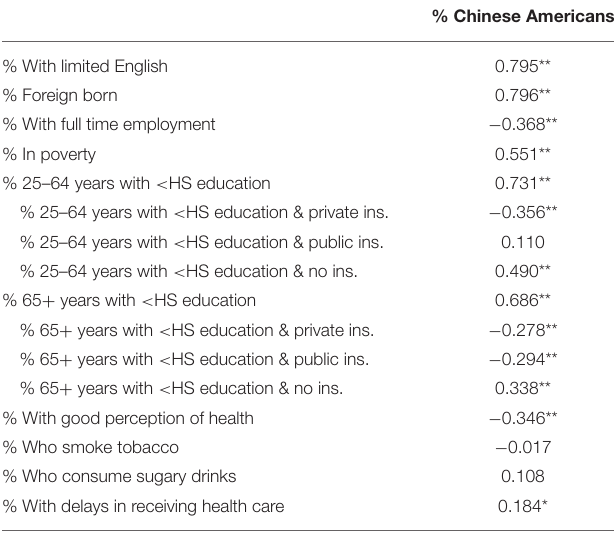
TABLE 4 | Spearman correlation coefficients for sociodemographic characteristics and community health indicators correlated with the proportion of Chinese Americans in ethnic-enclave Census